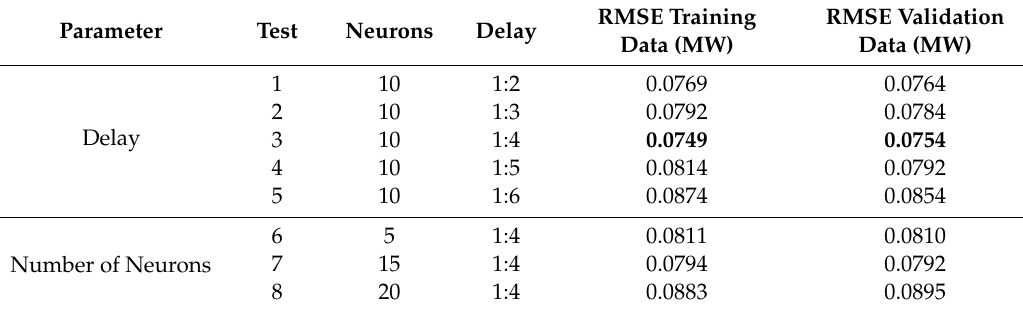
Table 7. Structure design test for option 5.